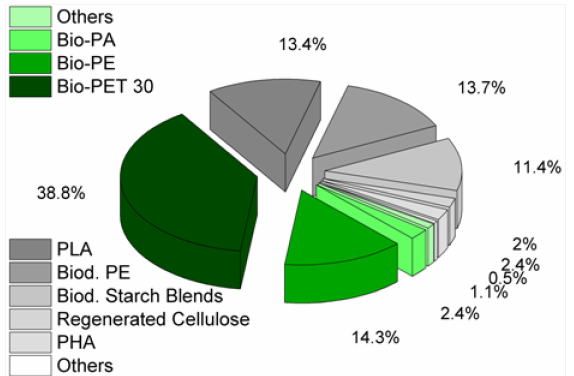
Figure 1. Global market of bio-based/non-biodegradable (green) and biodegradable (grey) plastics in 2012 with a total volume of 1.4 million tons [3].